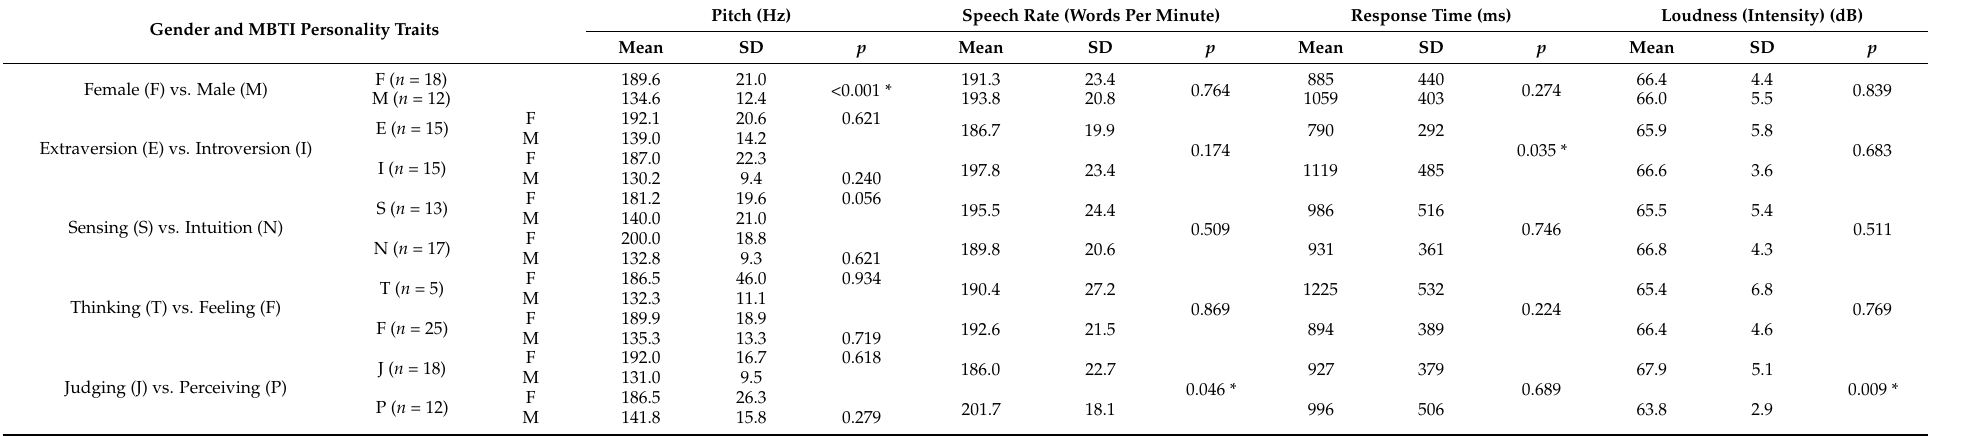
Table 2. Statistical analysis results ( p -values) on the non-lexical characteristics of the speech data.